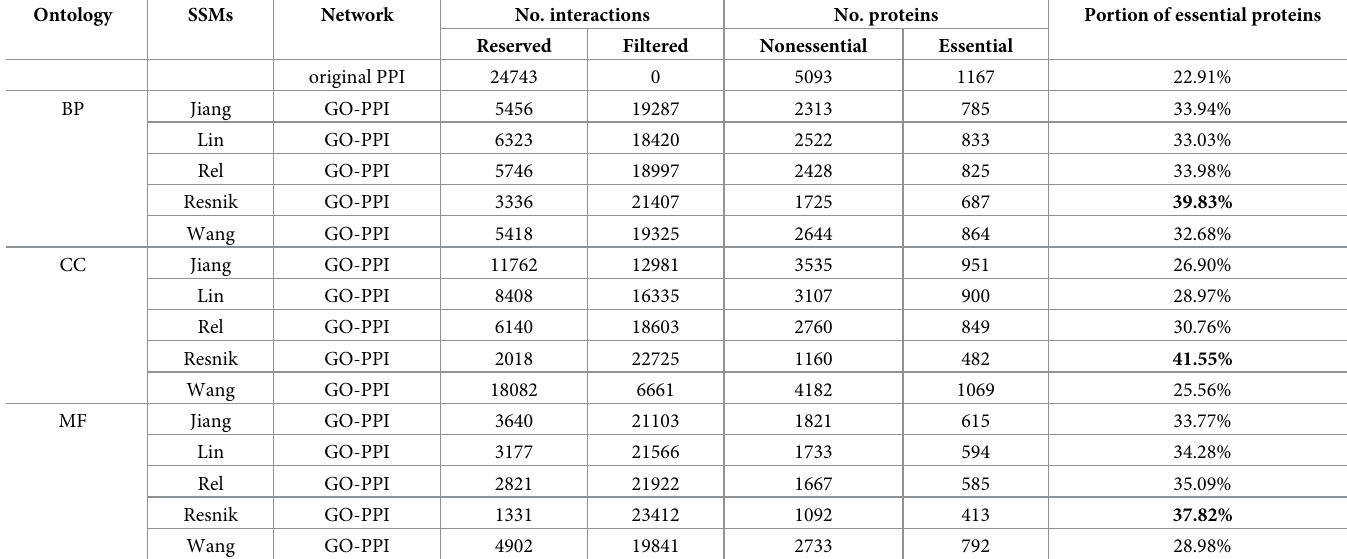
Table 2. The number of interactions and the portions of essential proteins under the original PPI network and GO-PPI network for the YDIP dataset. Ontology